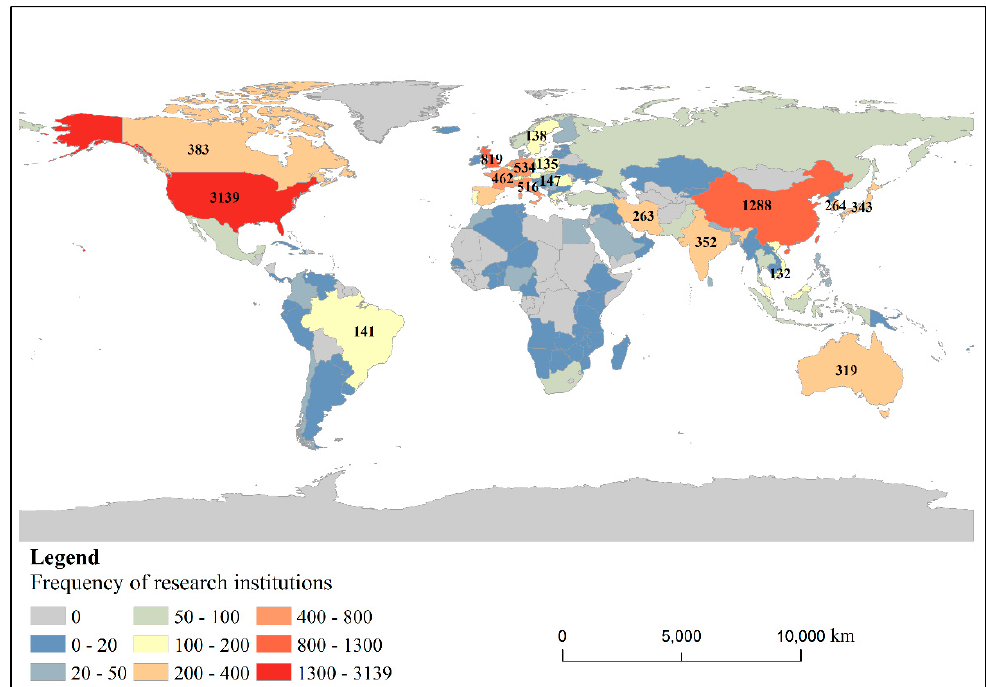
Figure 5. Spatial distribution of flood disaster research institutions (only the top 20 countries are labeled).